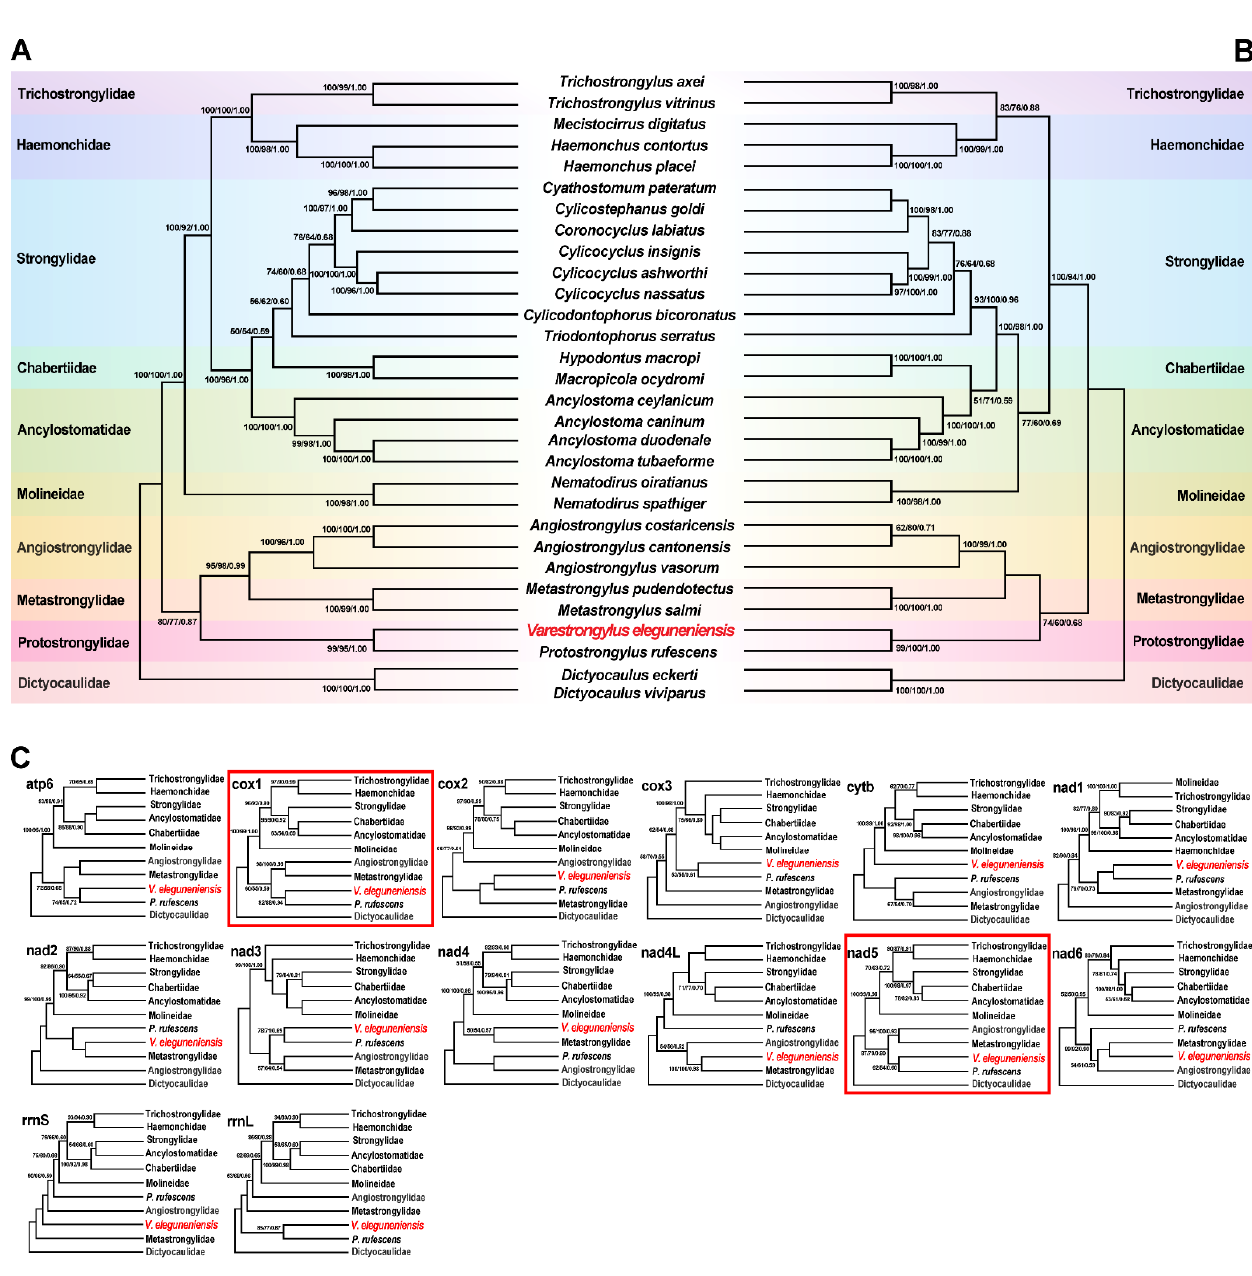
Figure 7. Phylogenies were inferred using three methods (MP, ML, and BI) based on mtDNA datasets containing 12 PCGs and two rRNAs. Dictyocaulus eckerti and Dictyocaulus viviparus are used as the outgroups. Different colored regions represent different families. ( A ), Phylogenetic tree based on the concatenated nucleotide sequences of the 12 PCGs; ( B ), Phylogenetic tree based on the concatenated amino acid sequences of the 12 PCGs; ( C ), Phylogenetic trees based on nucleotide sequences of 14 individual genes (12 PCGs and two rRNAs). The phylogenetic trees consistent with the trees in ( A , B ) are marked with red line boxes. The species sequenced in this study is shown in red fonts. The numbers along the branches indicate bootstrap values/posterior probabilities resulting from different analyses in the order MP/ML/BI.